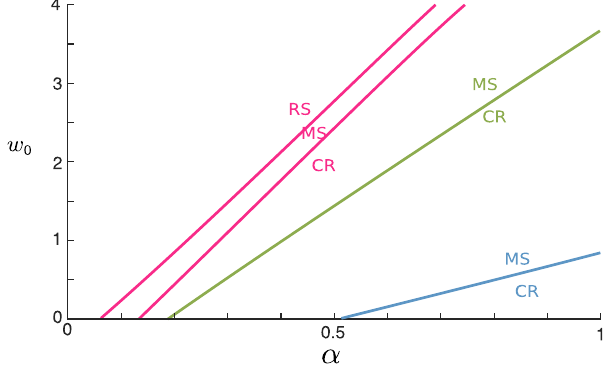
FIG. 13. Two-parameter bifurcation diagram of the simplified system [Eq. (2)] with respect to α and w 0 for various values of the coupling strength: J ¼ 2 . 5 (pink), J ¼ 1 . 5 (green), and J ¼ 0 . 5 (blue). RS, attraction to the resting state; MS, attraction to mixed states; CR, chain reaction: attraction to the pioneer fixed point. No codimension-two bifurcation is found, indicating no quali- tative change in the dynamics as w 0 is modified (e.g., when noise is varied).